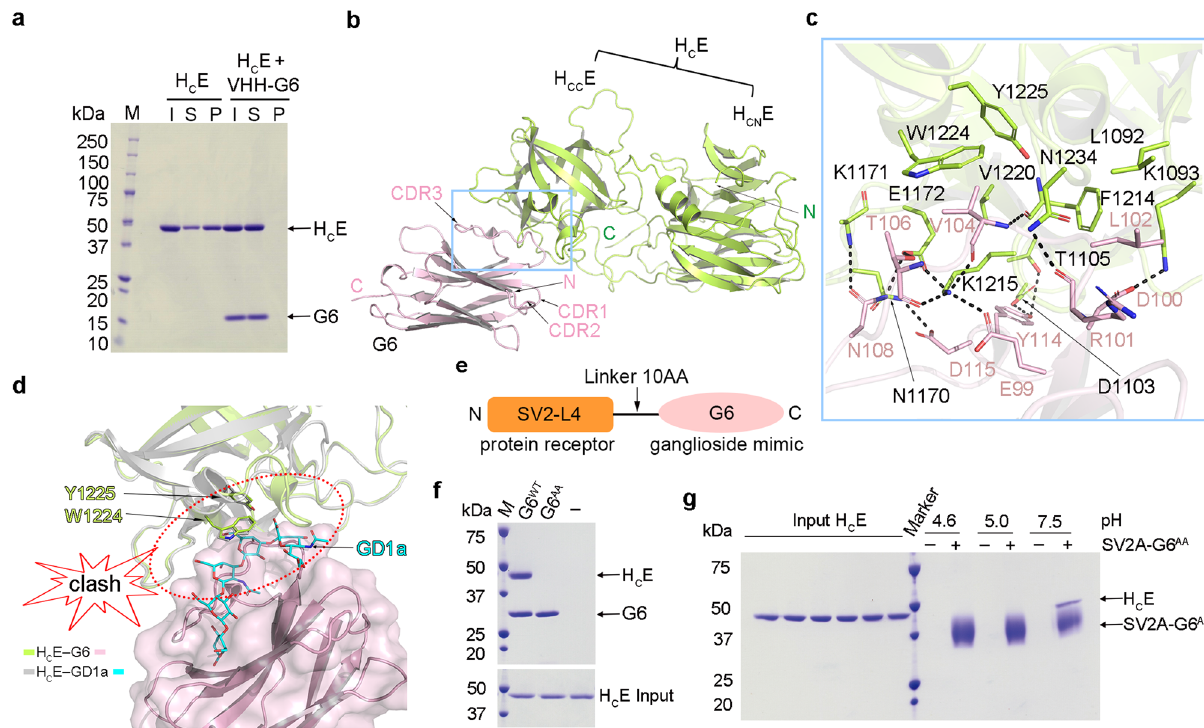
Fig. 1 | Structure of the H C E – G6 complex and the designs of SV2A – G6 fusion protein. a H C E pre-incubated with or without G6 was incubated with liposomes containing 70/20/10mol% BrPC/DOPS/GT1b. After liposomes were pelleted, H C E and G6 in the input (I), supernatant (S), and pellet (P) fractions were analyzed by SDS – PAGE and Coomassie blue staining (a representative result is shown, n =3). b Cartoon representation of the H C E – G6 complex with H C E colored in lemon and G6 in pink. The N- and C-terminal subdomains of H C E are referred to as H CN E and H CC E, respectively. c A close-up view of the interface between H C E and G6 is highlightedintheblueboxin( b ).Keyinteractingresiduesareshownassticks. d G6 occupies the ganglioside-binding pocket on H C E. The G6-bound H C E (lemon